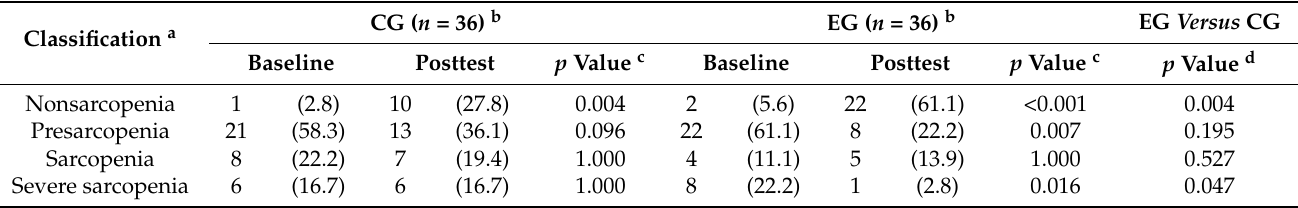
Table 4. Effects of protein supplementation plus elastic resistance exercise on